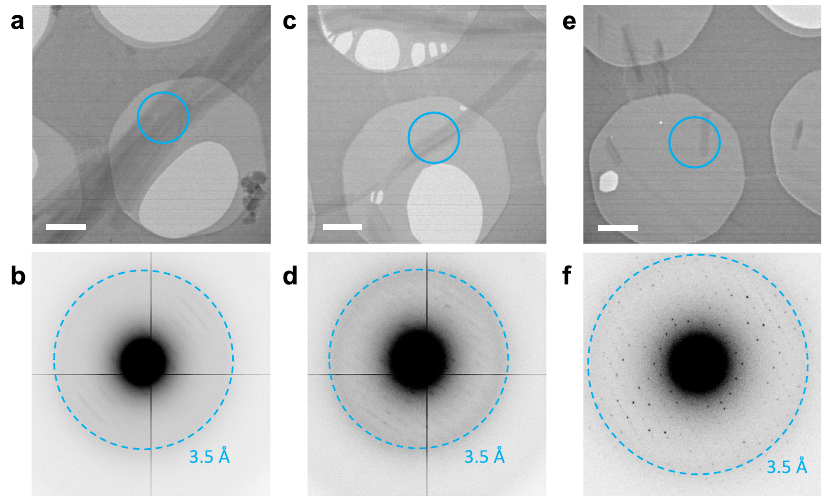
Fig. 2 MicroED data collection from MyD88 TIR microcrystals. a , b Electron micrograph of aggregated microcrystals, only showing poor-quality diffraction data. Scale bar, 1 µ m. c , d Multiple microcrystals are overlapping, showing multiple lattices in their corresponding diffraction patterns, complicating data indexing. Scale bar, 1 µ m. e , f Single hydrated microcrystal, showing high-quality diffraction data up to 3.0 Å resolution. Scale bar, 1 µ m. The cyan rings on the micrographs indicate the 1.5 μ m diameter parallel beam, de fi ned by the selected area aperture, used for MicroED data collection. Electron diffraction patterns were collected with an angular increment of 0.68° per frame, at a dose rate of 0.12 e − /Å 2 per frame. The data in a – f are representative of three EM grids prepared using 3 µ l of a 1 : 50 MAL TIR : MyD88 TIR crystal solution.